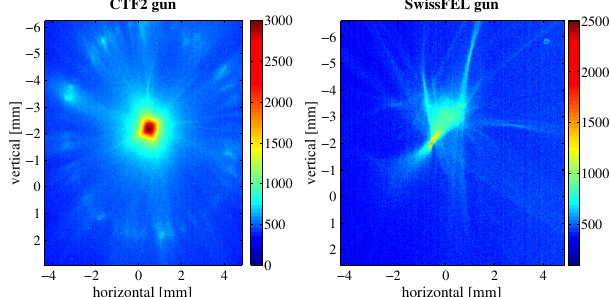
FIG. 13. Dark current beam imaged on a YAG:Ce screen near the gun exit for the CTF2 (left) and SwissFEL (right) gun. In both cases the electrons are focused with the gun solenoid.